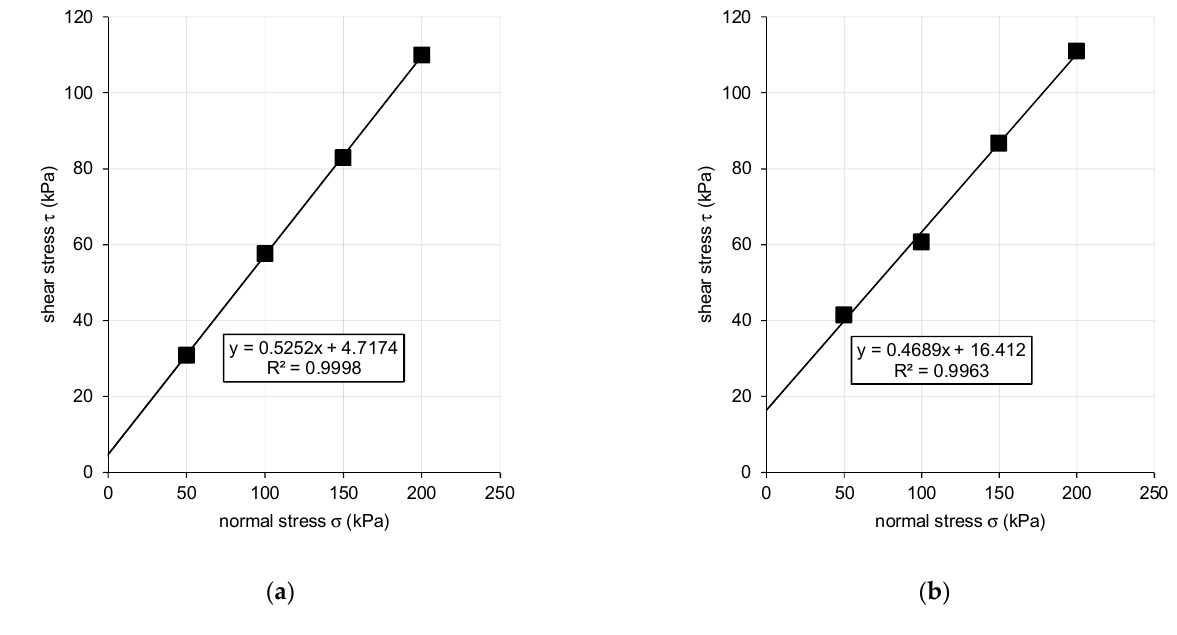
Figure 17. Regression curve for normal stress–shear stress relation. ( a ) Original sample; ( b ) Boiled sample. Shear strength parameters are φ ' = 27.7° for original sand sample and c' = 4.7 kPa; φ ' = 25.1° and c' = 16.4 kPa for boiled sand sample.